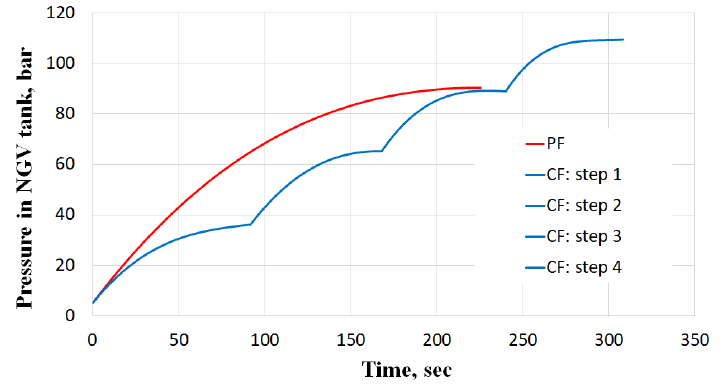
Fig. 2. Numerical simulation of complete cascade fuelling (CF) and parallel fuelling